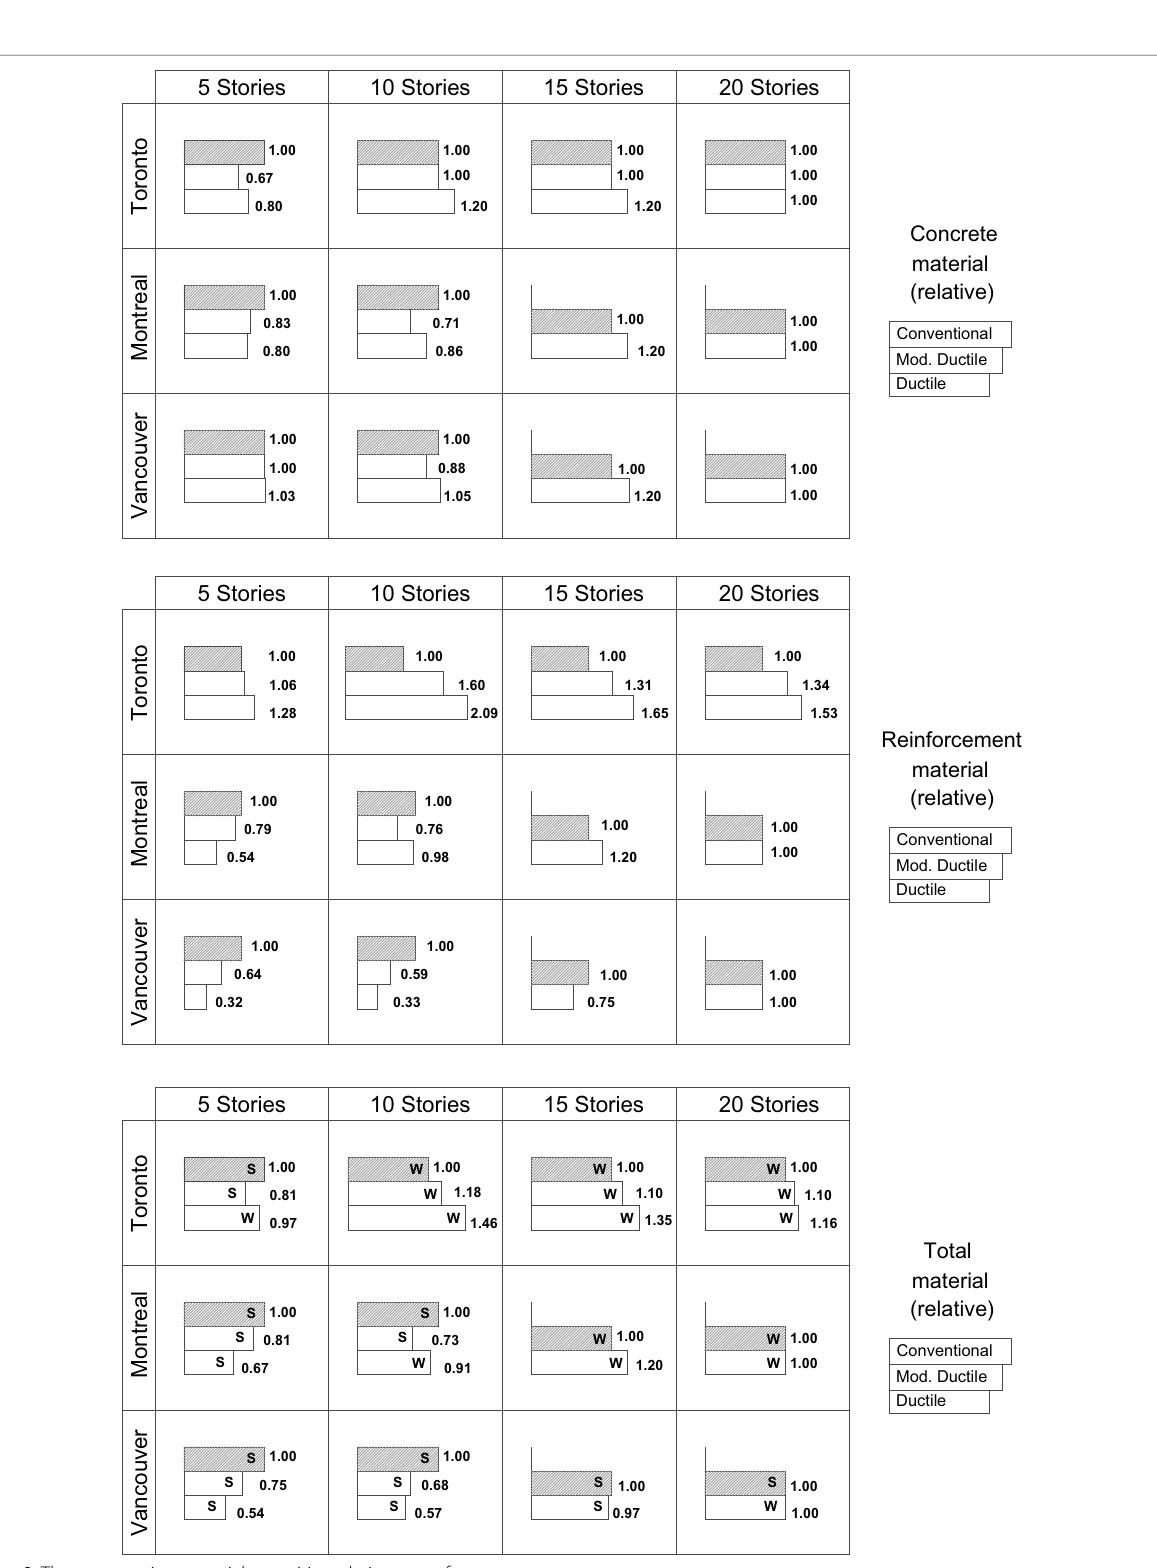
Fig. 4 The construction material quantities relative to a reference